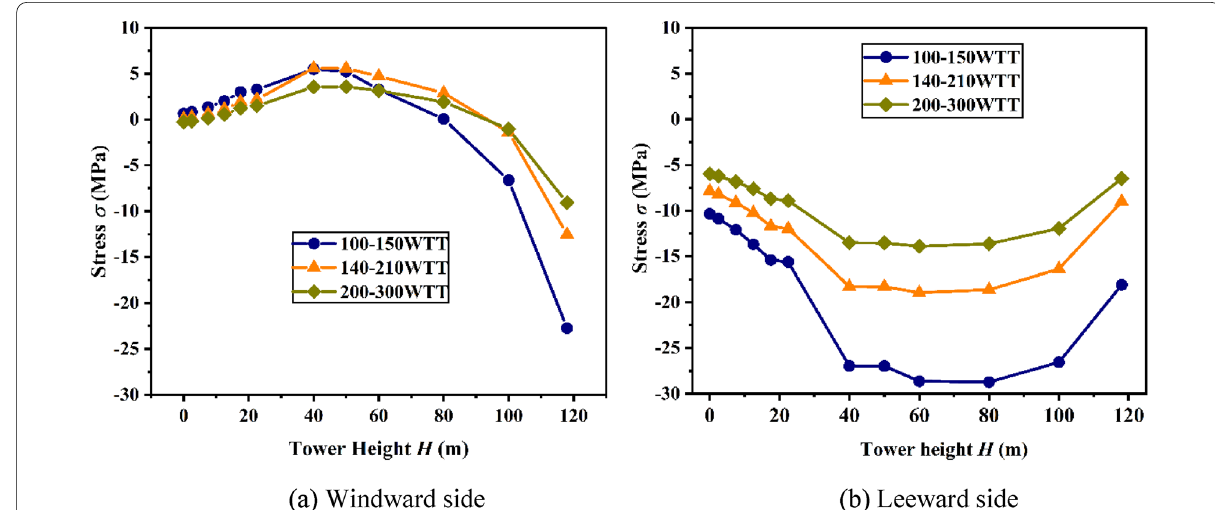
Fig. 5 Stress distribution of UHPC segment in towers with various wall thickness.